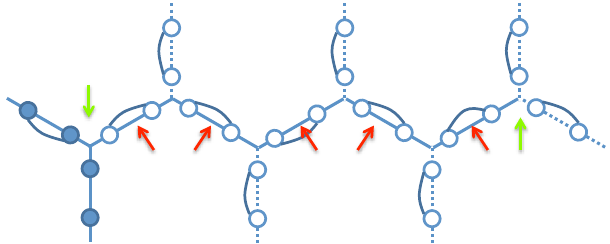
FIG. 10. Possible configuration where no isolated spin- 1 = 2 ’ s appear near the end of strings, showing that such excitations are confined. The solid lines have a semion label, and dashed lines have a trivial label. The violated vertices are indicated with green arrows, and red arrows indicate edges that are not in a ground state of H 0